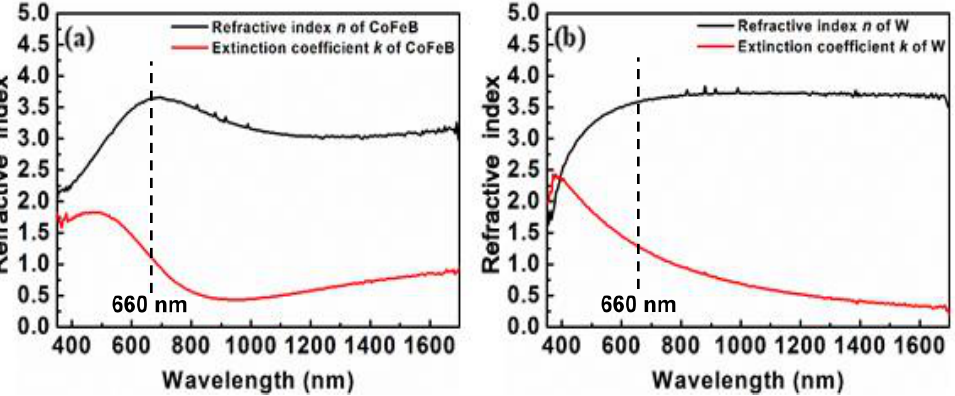
Figure 3. Wavelength-dependent refractive index n and extinction coefficient k of ( a ) CoFeB layers and ( b ) W layers. and ( b ) W